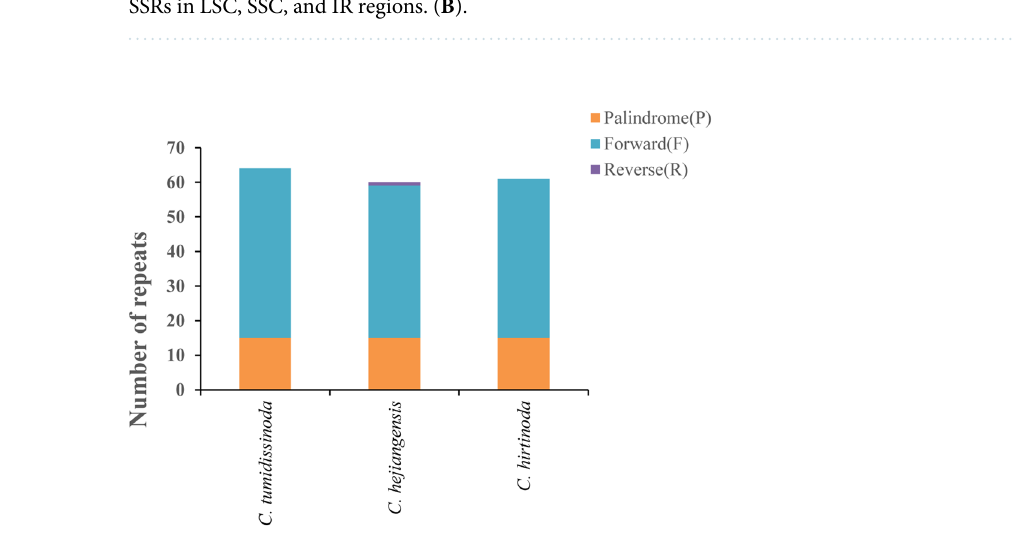
Figure 3. Information of chloroplast genome repeats of Chimonobambusa genus